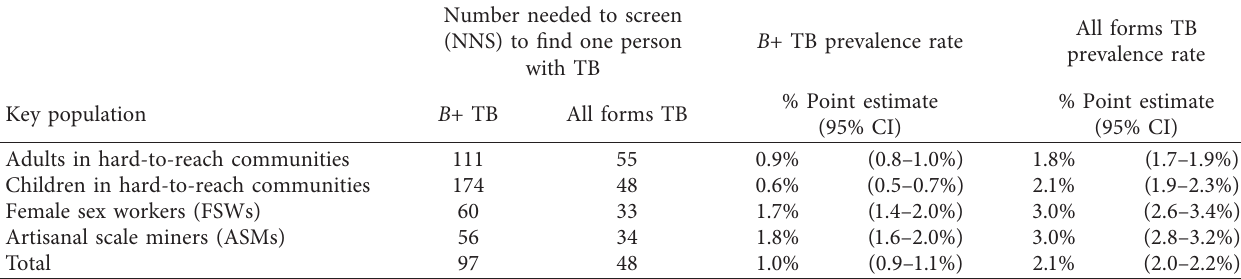
Table 4: Estimated prevalence of TB, with population group